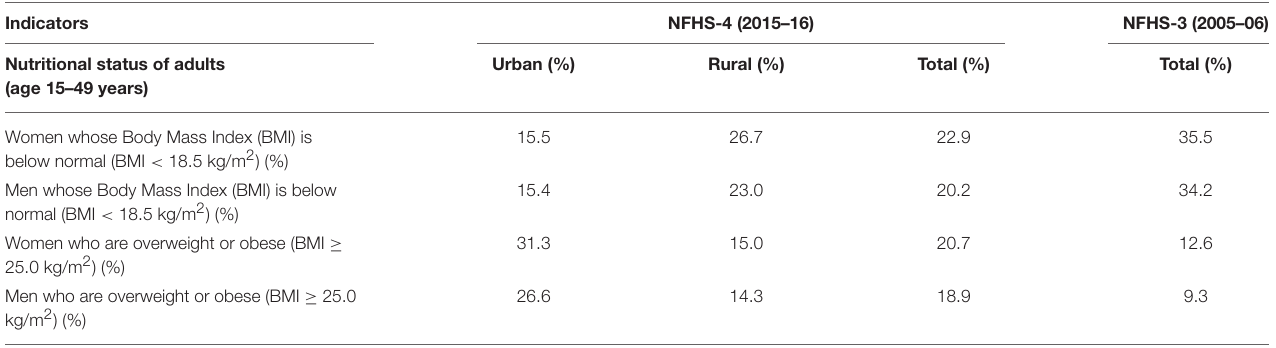
TABLE 1 | Nutritional status of adults in India showing trends in malnutrition including a decrease in underweight adults and an increase in overweight adults of both genders from 2005–6 to 2015–16 http://rchiips.org/NFHS/pdf/NFHS4/India.pdf.